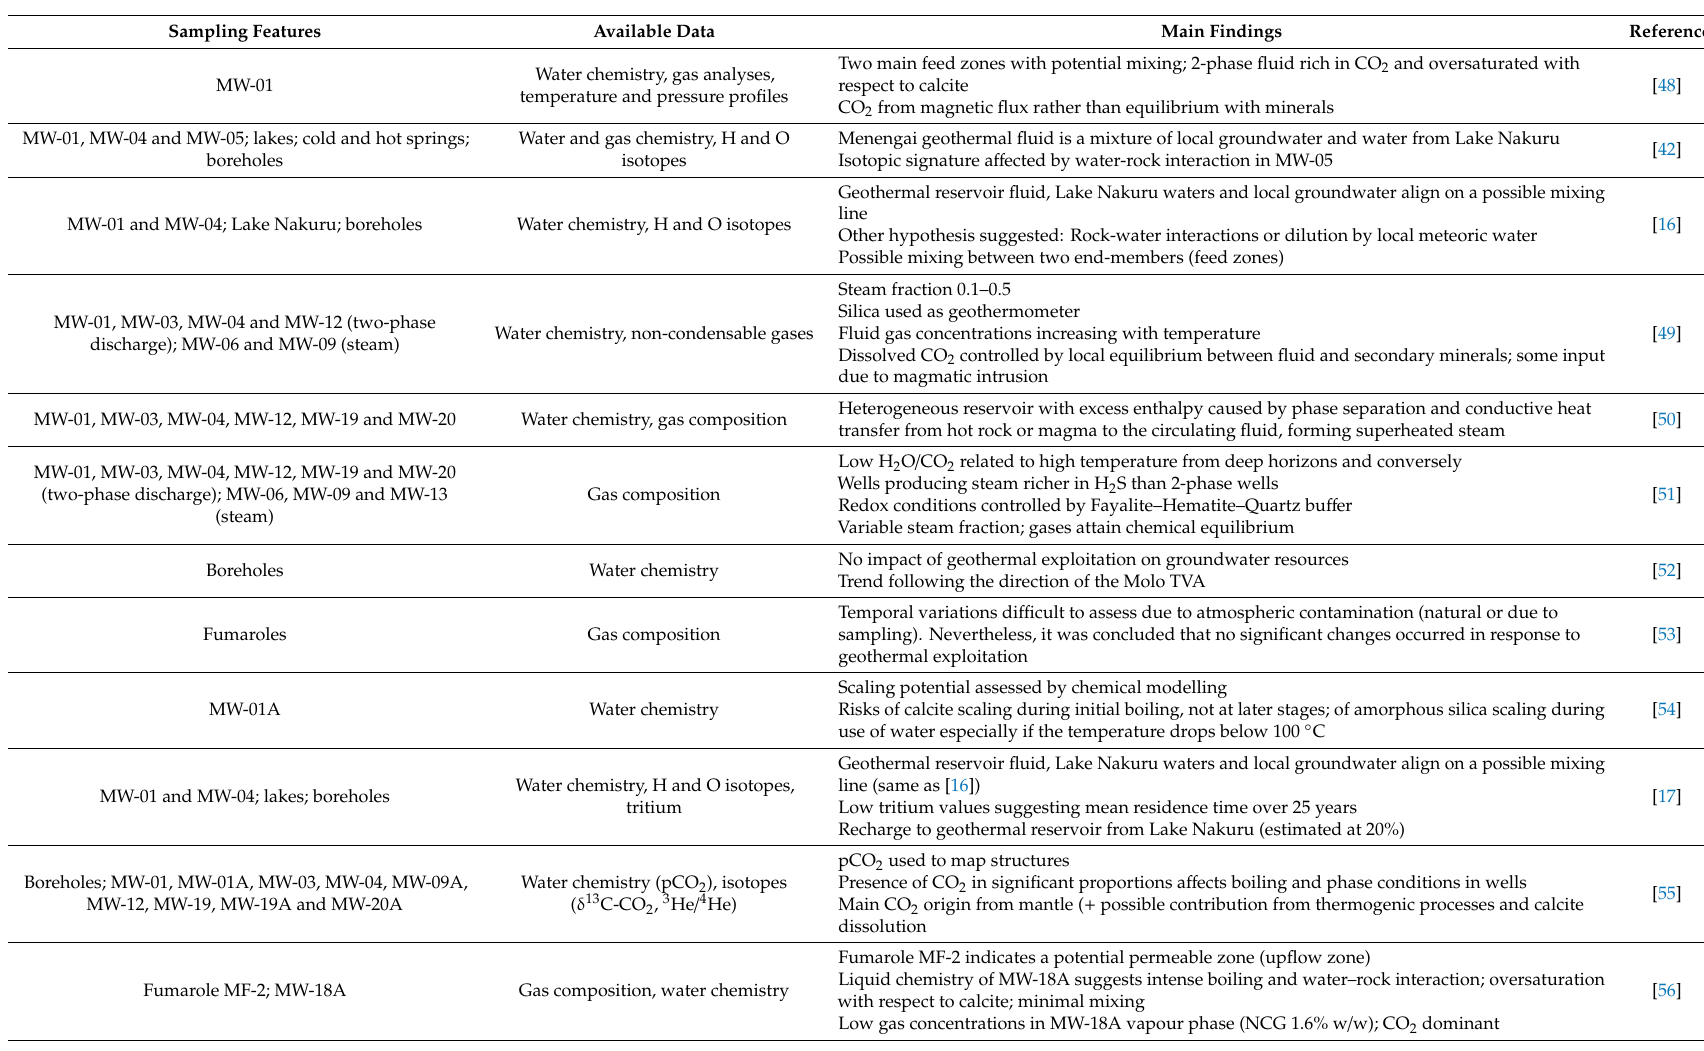
Table 1. Summary of hydrogeochemical studies publicly available focusing on Menengai geothermal field (from oldest to most